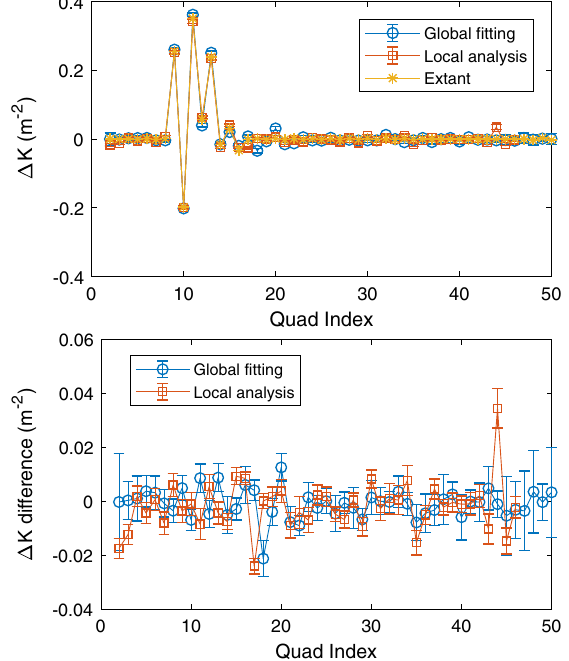
FIG. 10. Top: Gradient changes from the design model, Δ K , using global fitting, local analysis, or magnet calibration data ( “ Extant model ” ) are compared for the L3 linac quadrupoles. Bottom: difference of Δ K between measurements and the Extant model.